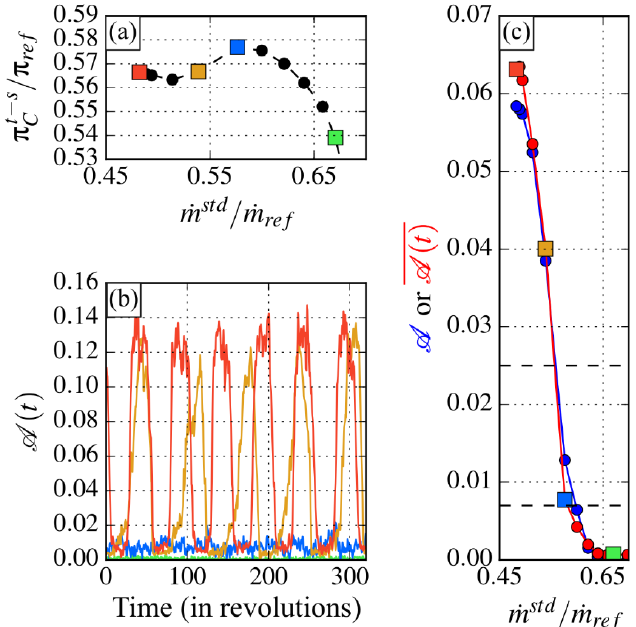
Figure 8. Unsteady evaluation of the alternate rate at isospeed C: ( a ) Considered operating points; ( b ) Unsteady alternate rate for the considered operating points; ( c ) Comparison of the time-averaged value of the unsteady alternate rate and the steady alternate rate.